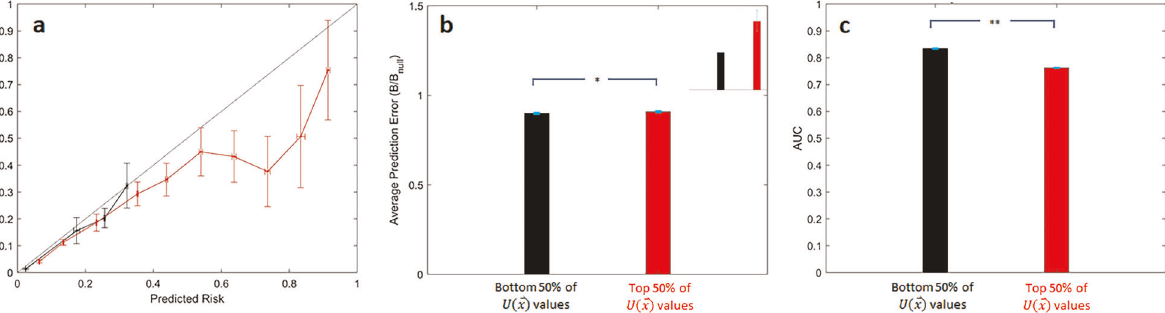
* Þ values) have worse performance. a Calibration